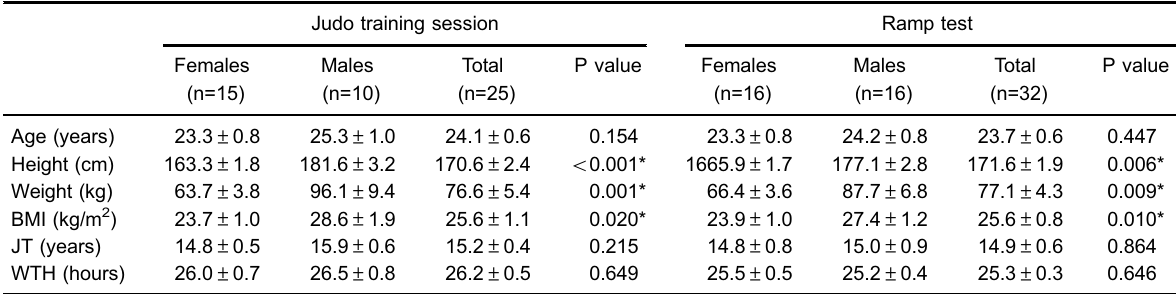
Table 1. Characteristics of volunteers.